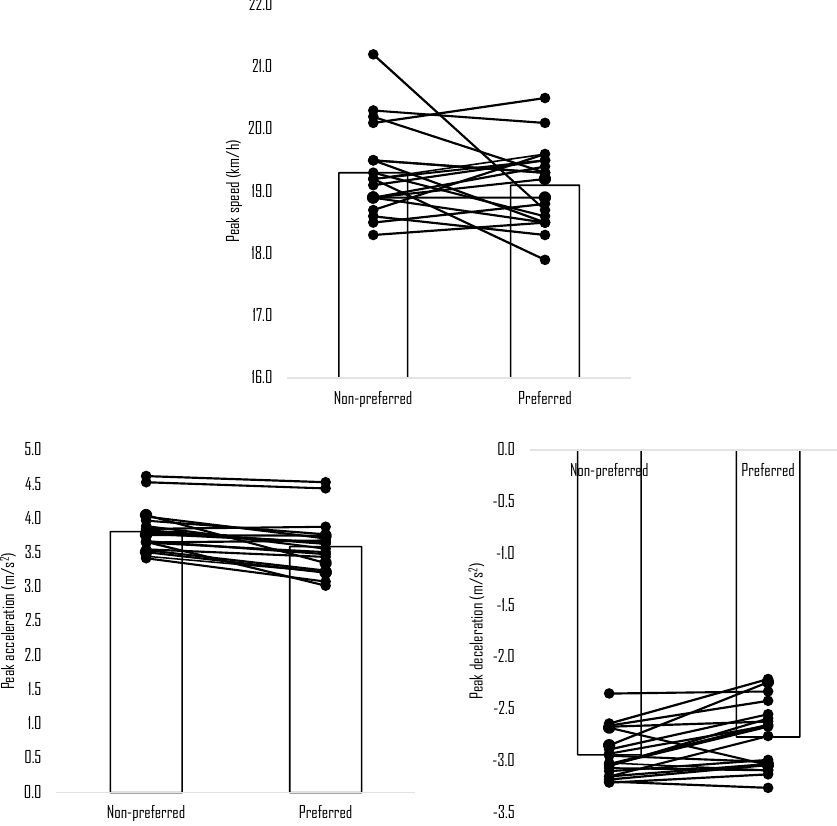
Figure 2. Descriptive statistics and within-players variation of kinematic measures between preferred and non- preferred